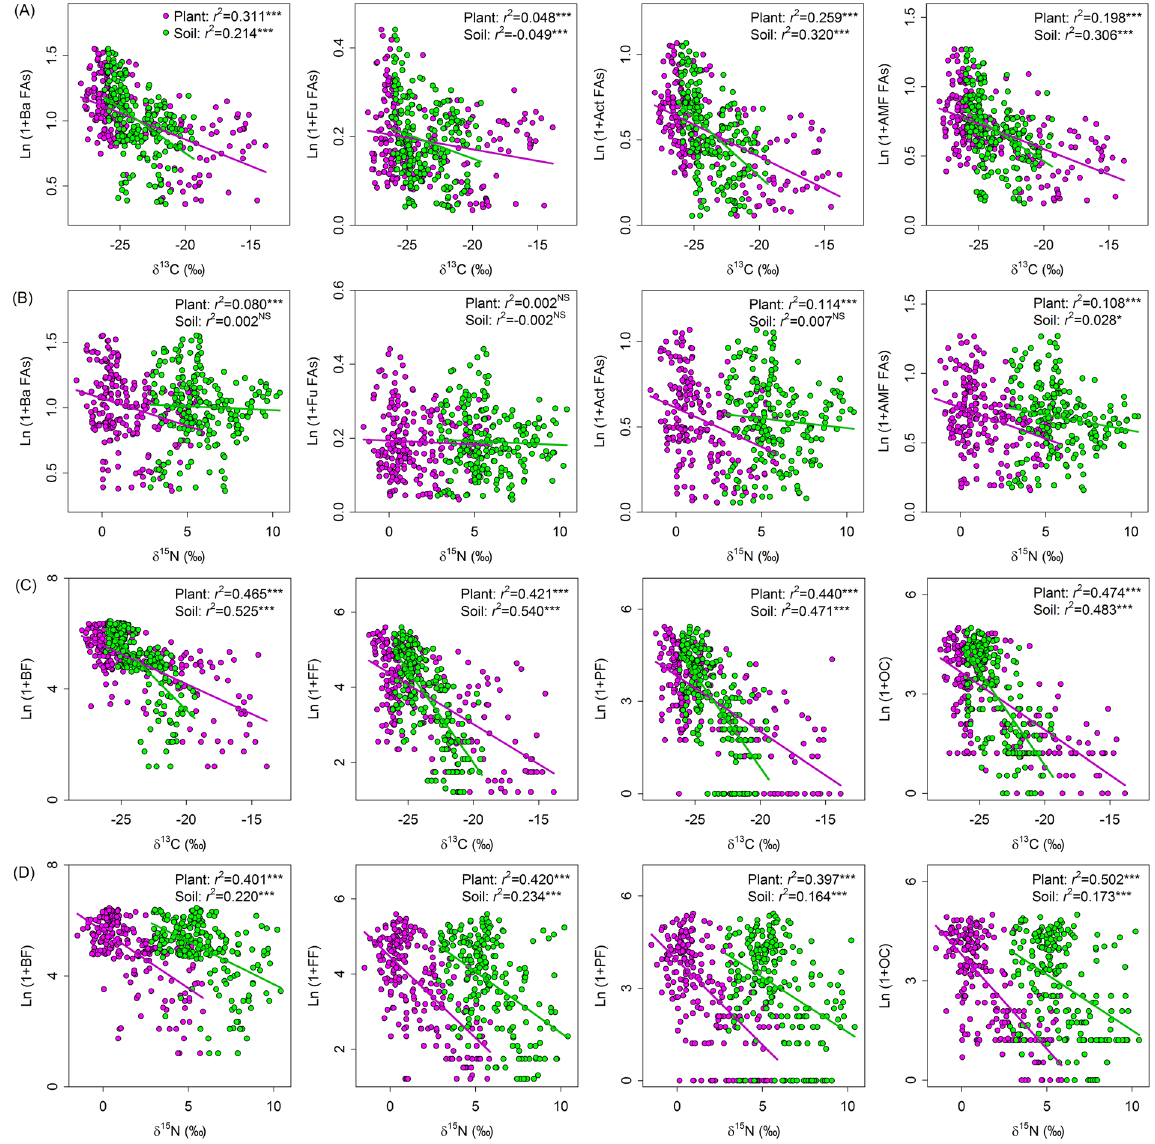
Figure 4. Relationships between additional microbial and nematode community variables and ( A and C ) δ 13 C isotopic compositions and ( B and D ) δ 15 N isotopic compositions of plants (pink symbols) and soils (green symbols) at the regional scale in the Mongolian grassland. Abbreviations are explained in Table 1. Regression analysis is indicated by r 2 and significance level (NS, P > 0.05; * P < 0.05; ** P < 0.01; *** P <